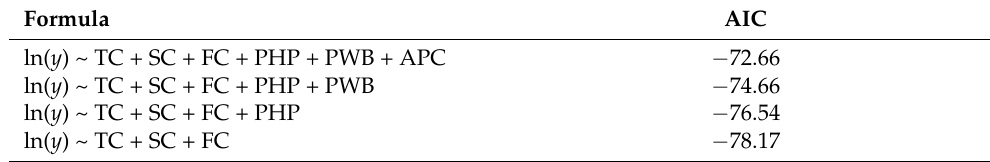
Table 1. Results of the stepwise regression for the multiple linear models.